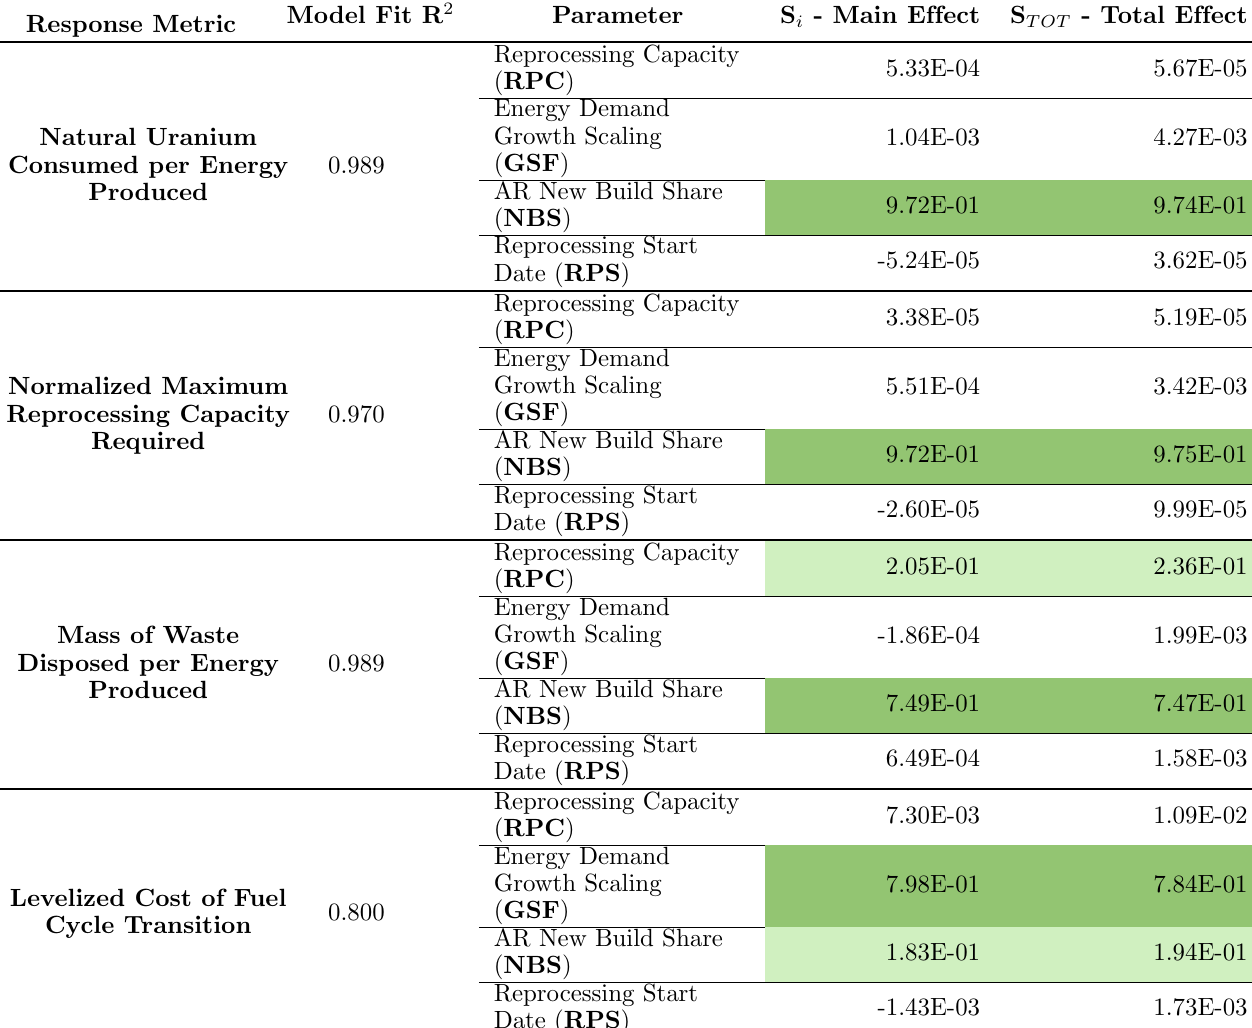
Table 4. Main effect indices and total effect indices for the quadratic regression surrogate model. Response